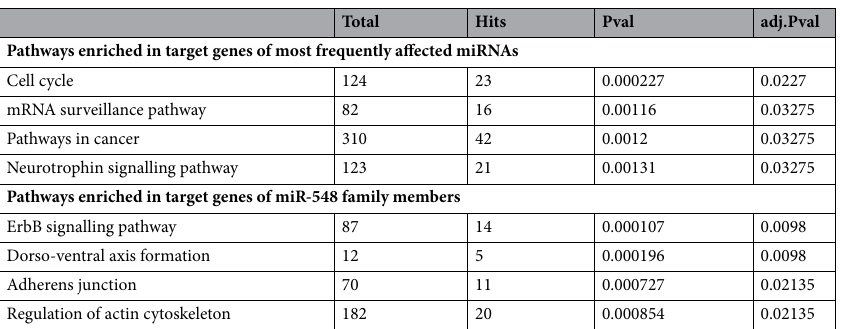
Table 3. KEGG pathways enriched in target genes of miRNAs and miR-548 family members most frequently affected by rare CNVs in CAKUT. Enrichment analysis was performed on target genes from the miRNA- gene interaction network (Figs. 2 and 3). Total – number of genes in the pathway; Hits – number of genes in miRNA–gene interaction network involved in the pathway; Pval – hypergeometric test; adj.Pval – adjustment for false discovery rate